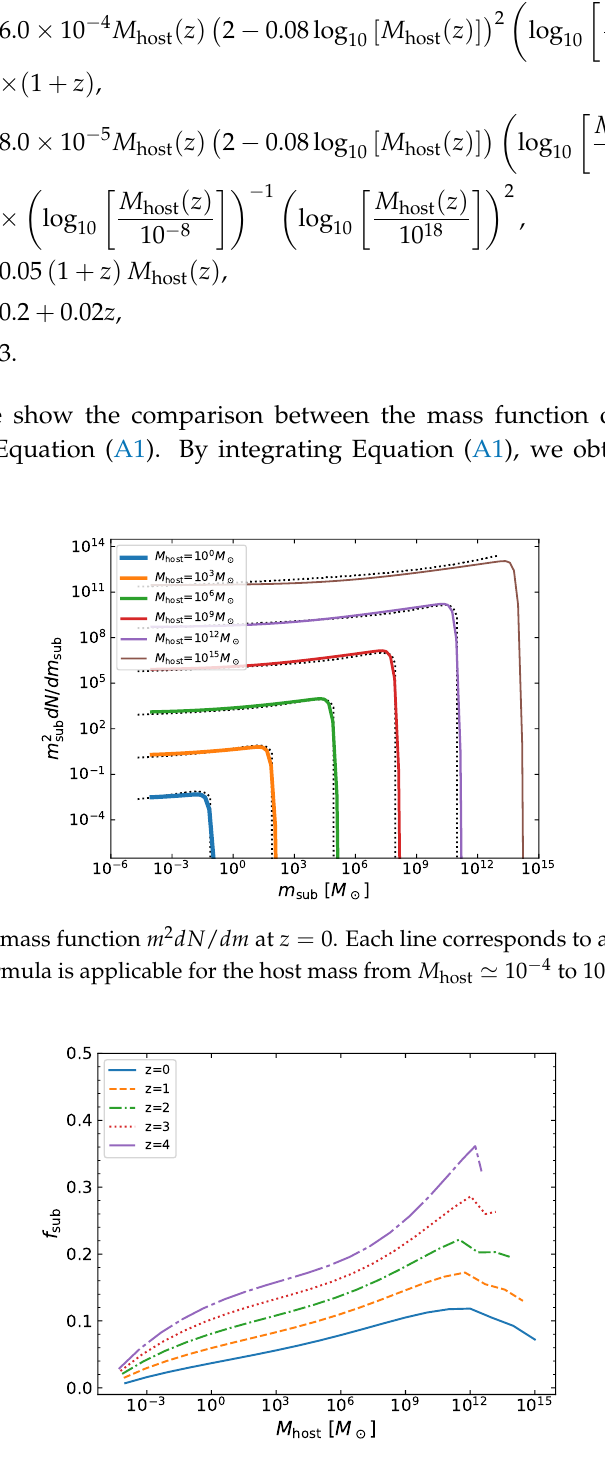
Figure A2. The subhalo mass fraction obtained by integrating Equation